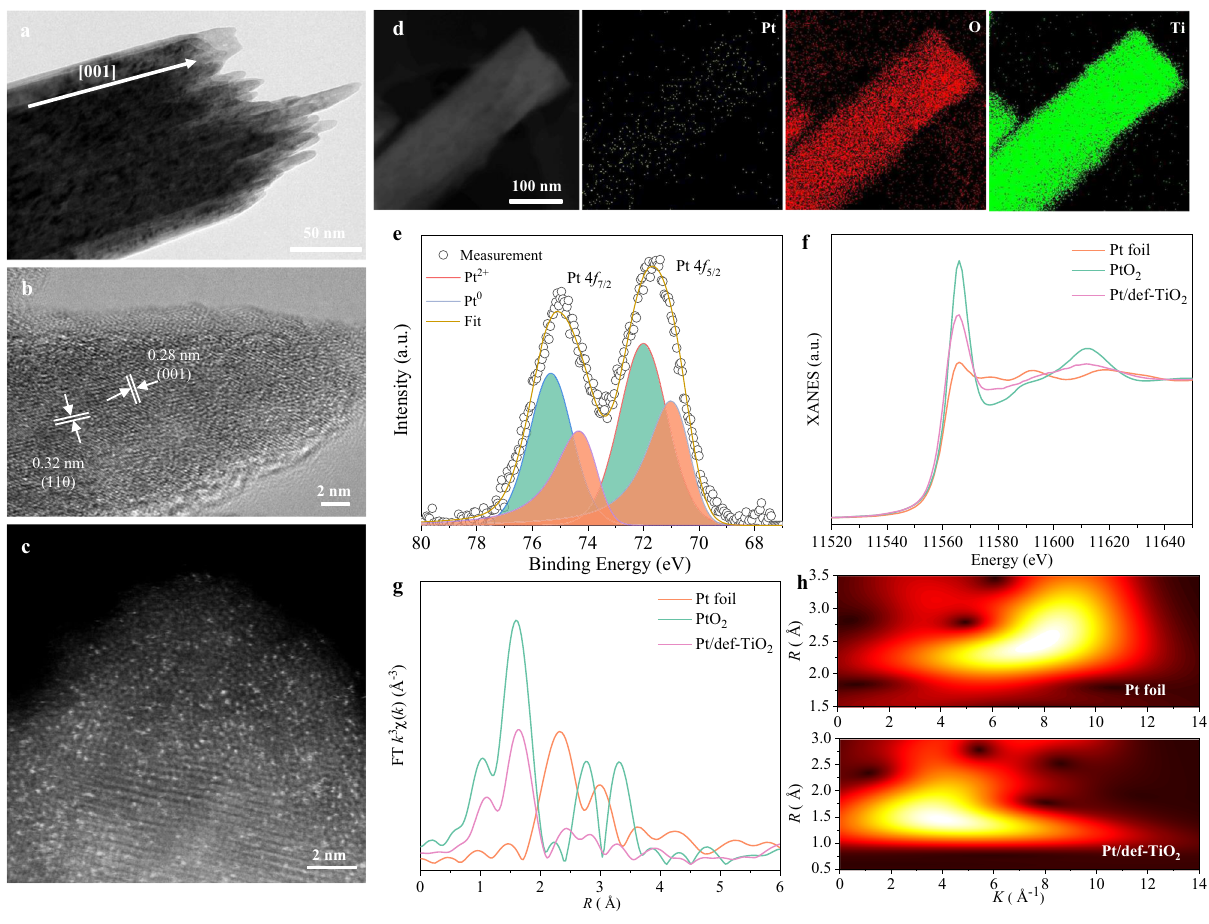
Fig. 3 | Identi fi cation of single atoms onthe defective TiO 2 nanorod. a TEM and ( b ) HR-TEM images of Pt/def-TiO 2 . c HAADF-STEM image of Pt/def-TiO 2 measured from a spherical aberration-corrected TEM. d STEM image and corresponding